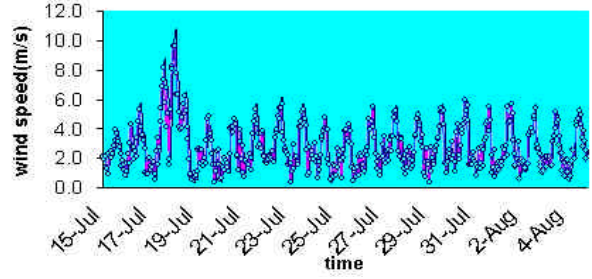
Figure11. Predicted (solid line) and measured (dotted line) wind speed(U 4.5 )